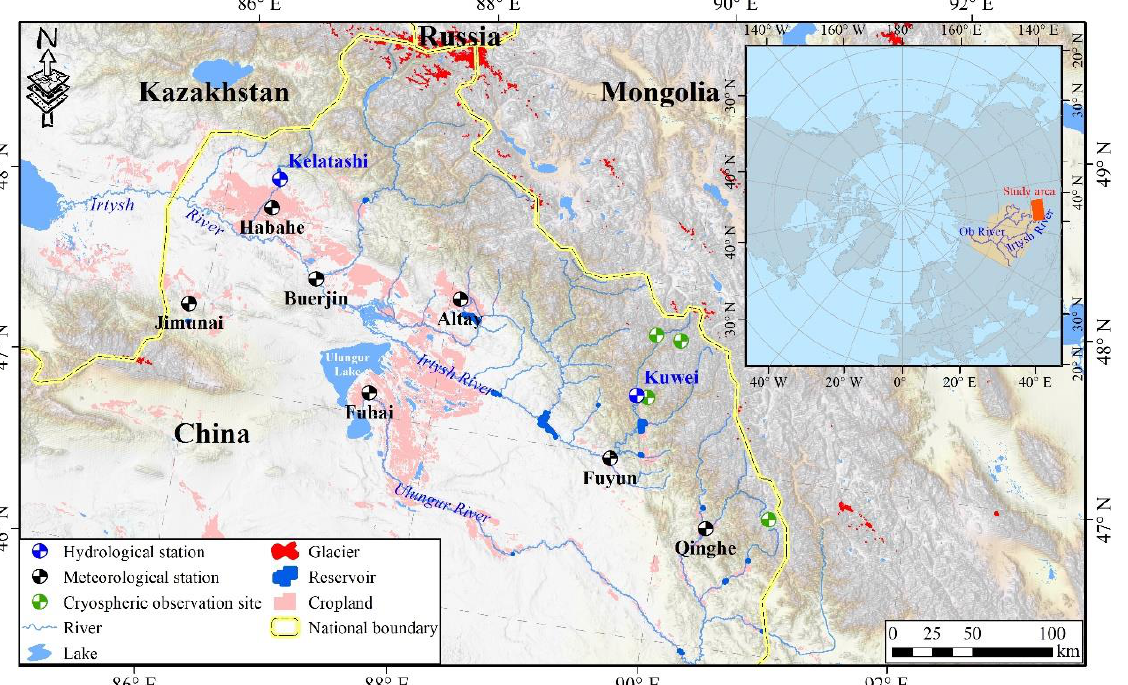
Figure 1. Map of the study area, with the locations of the meteorological and hydrological stations used in this study, as well as the reservoirs and lakes, cropland, and mountain glaciers indicated. The inset map shows the extent of the Altai Mountains (light brown), the location of the study area (box), and the major rivers in the region.